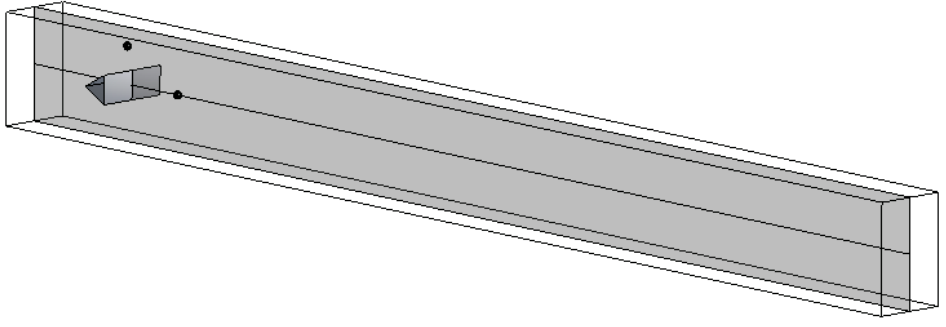
Figure 2. Topology of computational domain. Black balls indicate position of thermistor probes.